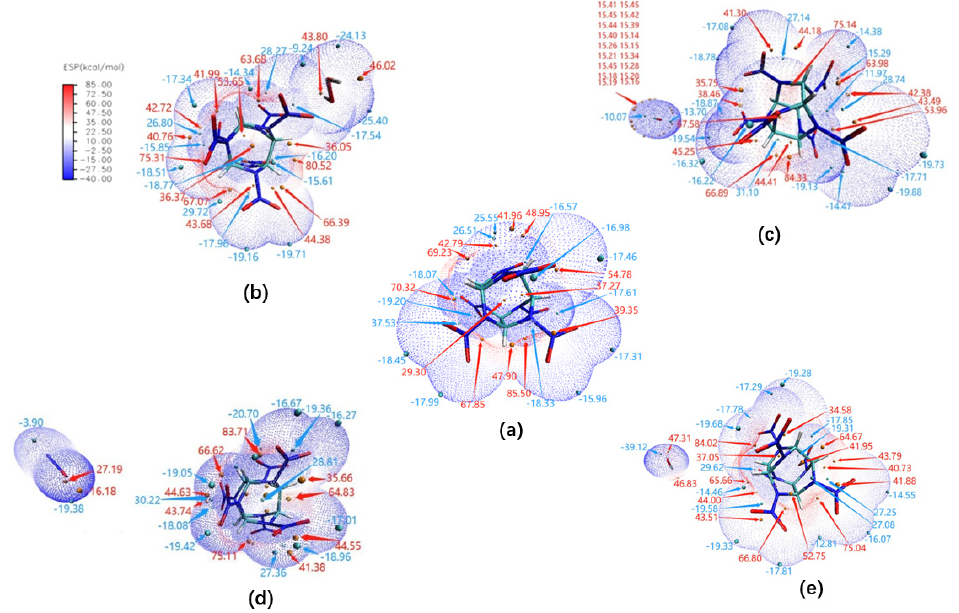
Figure 7. ESP—mapped molecular vdW surface of: ( a ) CL-20, ( b ) CL-20/H 2 O 2 , ( c ) CL-20/CO 2 , ( d ) CL-20/N 2 O, and ( e ) CL-20/H 2 O. The unit is in kcal · mol − 1 . Surface local minima and maxima of ESP are represented as green and orange spheres, respectively. The global minimum and maximum are labeled by blue and red colors, respectively.